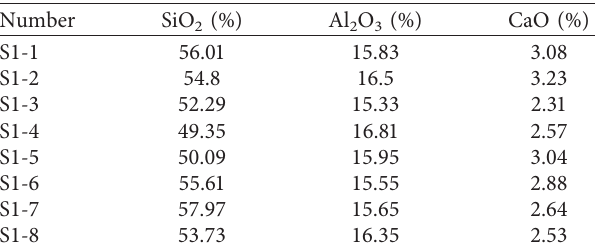
Figure 4: S1-1Mineral composition diagram of deep sandstone reservoir. Table 2: The main mineral composition of deep sandstone